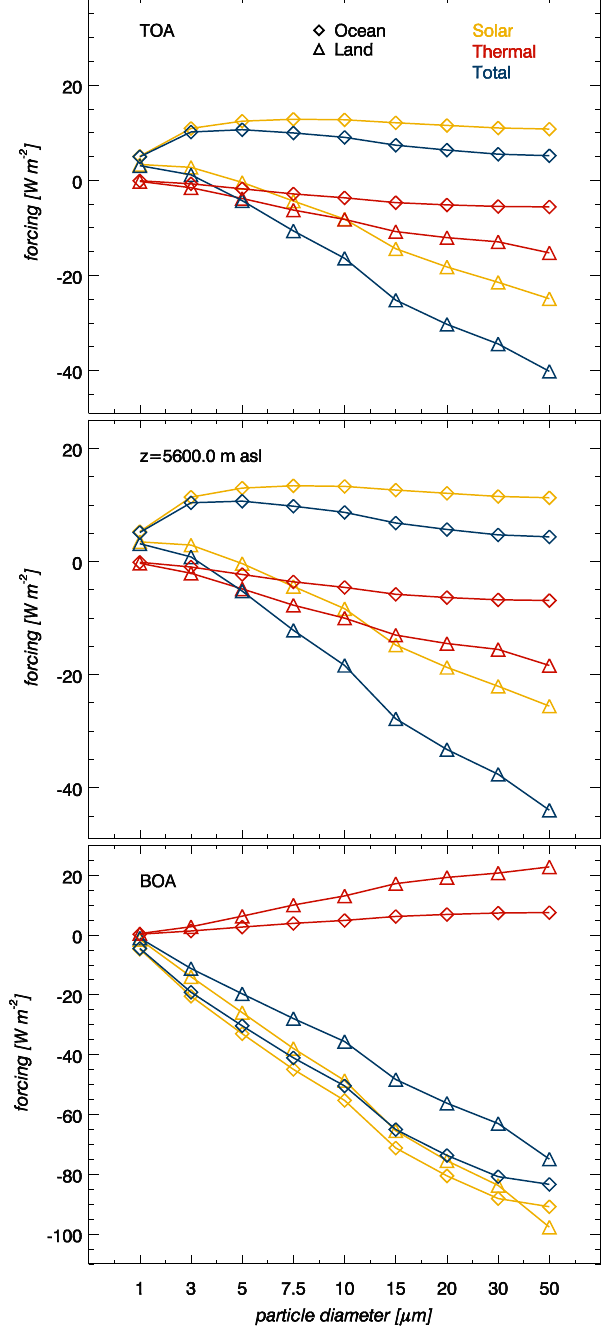
Fig. 14. Simulated solar, thermal and total forcings of the mineral dust plume, observed on 19 May over OZT site about noon, over a mean land and ocean surface as a function of the maximum parti- cle diameter D e , max (Sect. 4.1) assuming spherical model particles. For computational details see Sects. 3.4 and 3.6. (top) 1F( TOA ) , (centre) 1F(z) at the upper boundary of the dust layer at an altitude of z = 5 . 6kma.s.l. and (bottom) 1F( BOA )